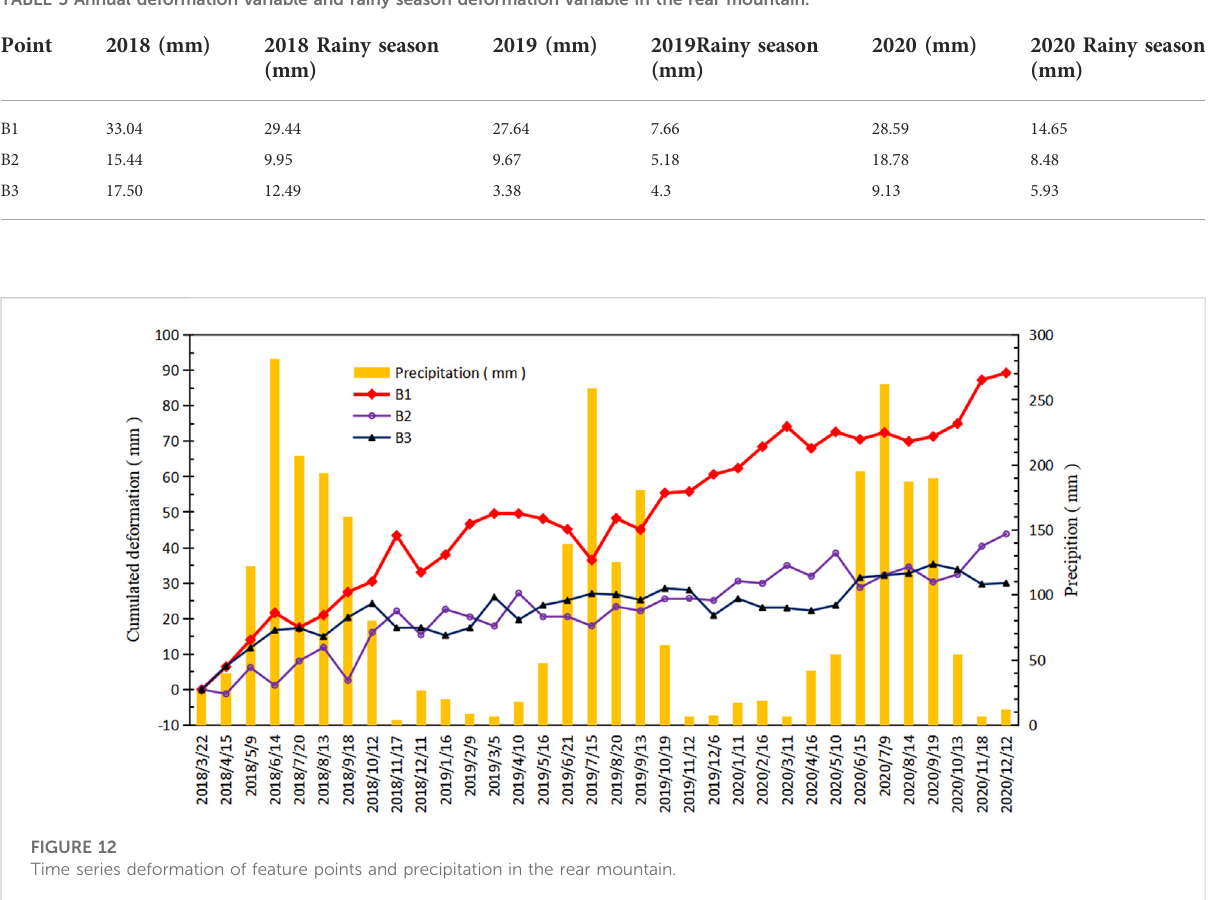
TABLE 5 Annual deformation variable and rainy season deformation variable in the rear mountain.